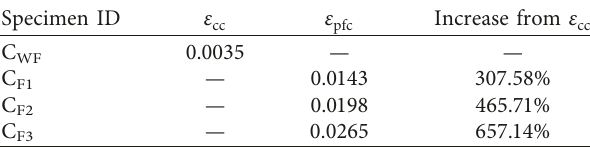
Table 9: Increase of strains at peak